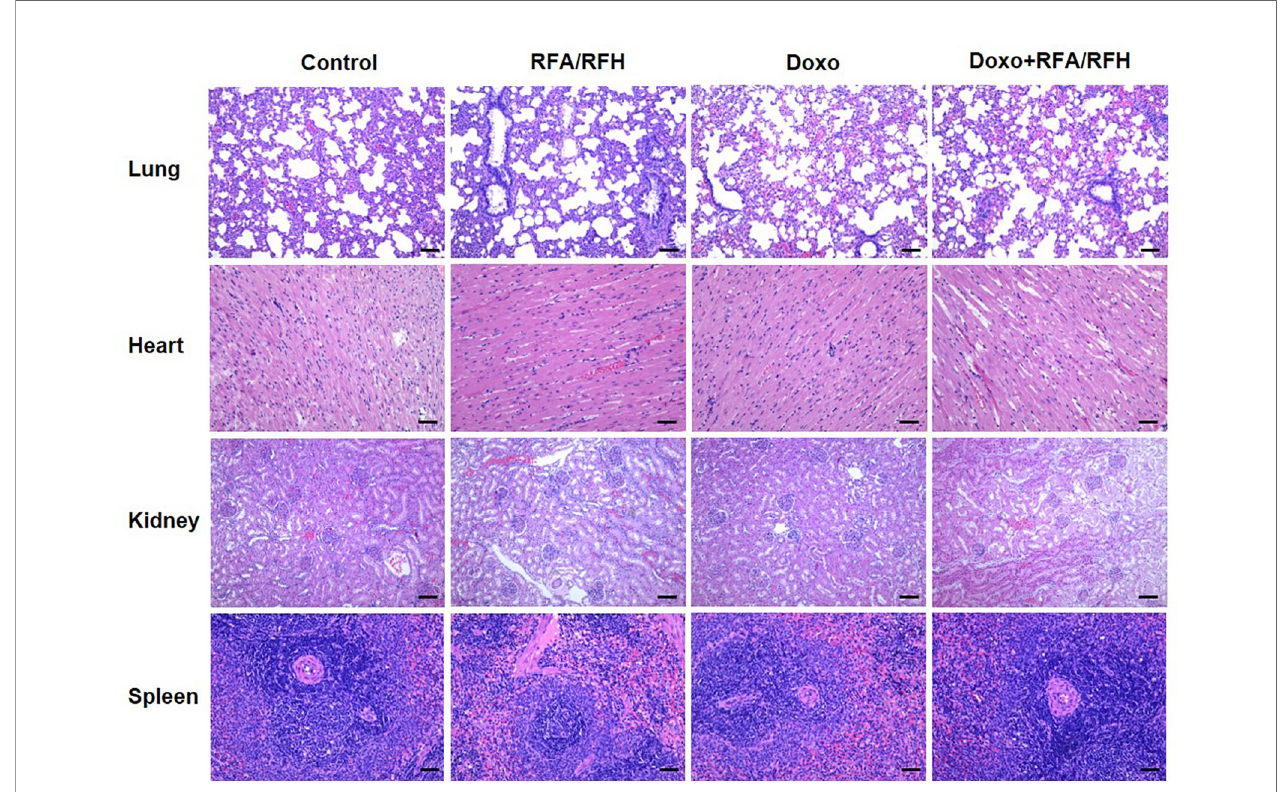
FIGURE 7 | Representative major organ tissue (lung, heart, kidney, and spleen) stained with H&E 2 week after treatment. Scale bar represents 100 m